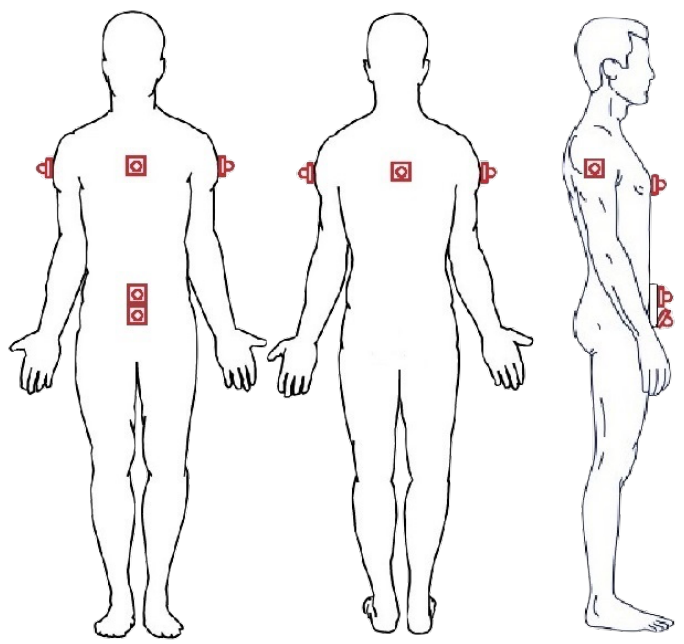
Figure 17. Experimental setup composed by six ultrasonic sensors: one sensor is attached in the middle of the chest, one is in the center of the back, two sensors are attached to the shoulders, and two are fixed to the waist (in turn, one pointing forward and one tilted down towards the floor). A first trial, whose results are shown in Figure 18, has been carried out in the house backyard with no obstacles.